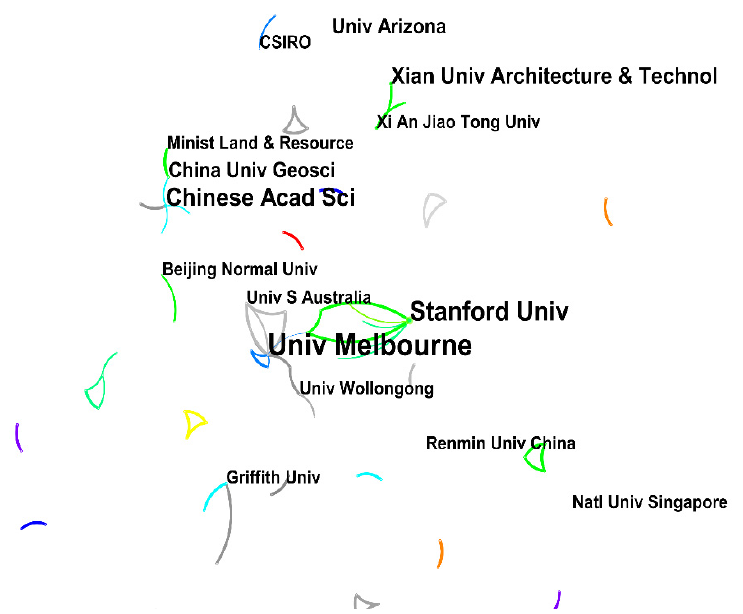
Figure 6. Cooperation network of domestic institutions.